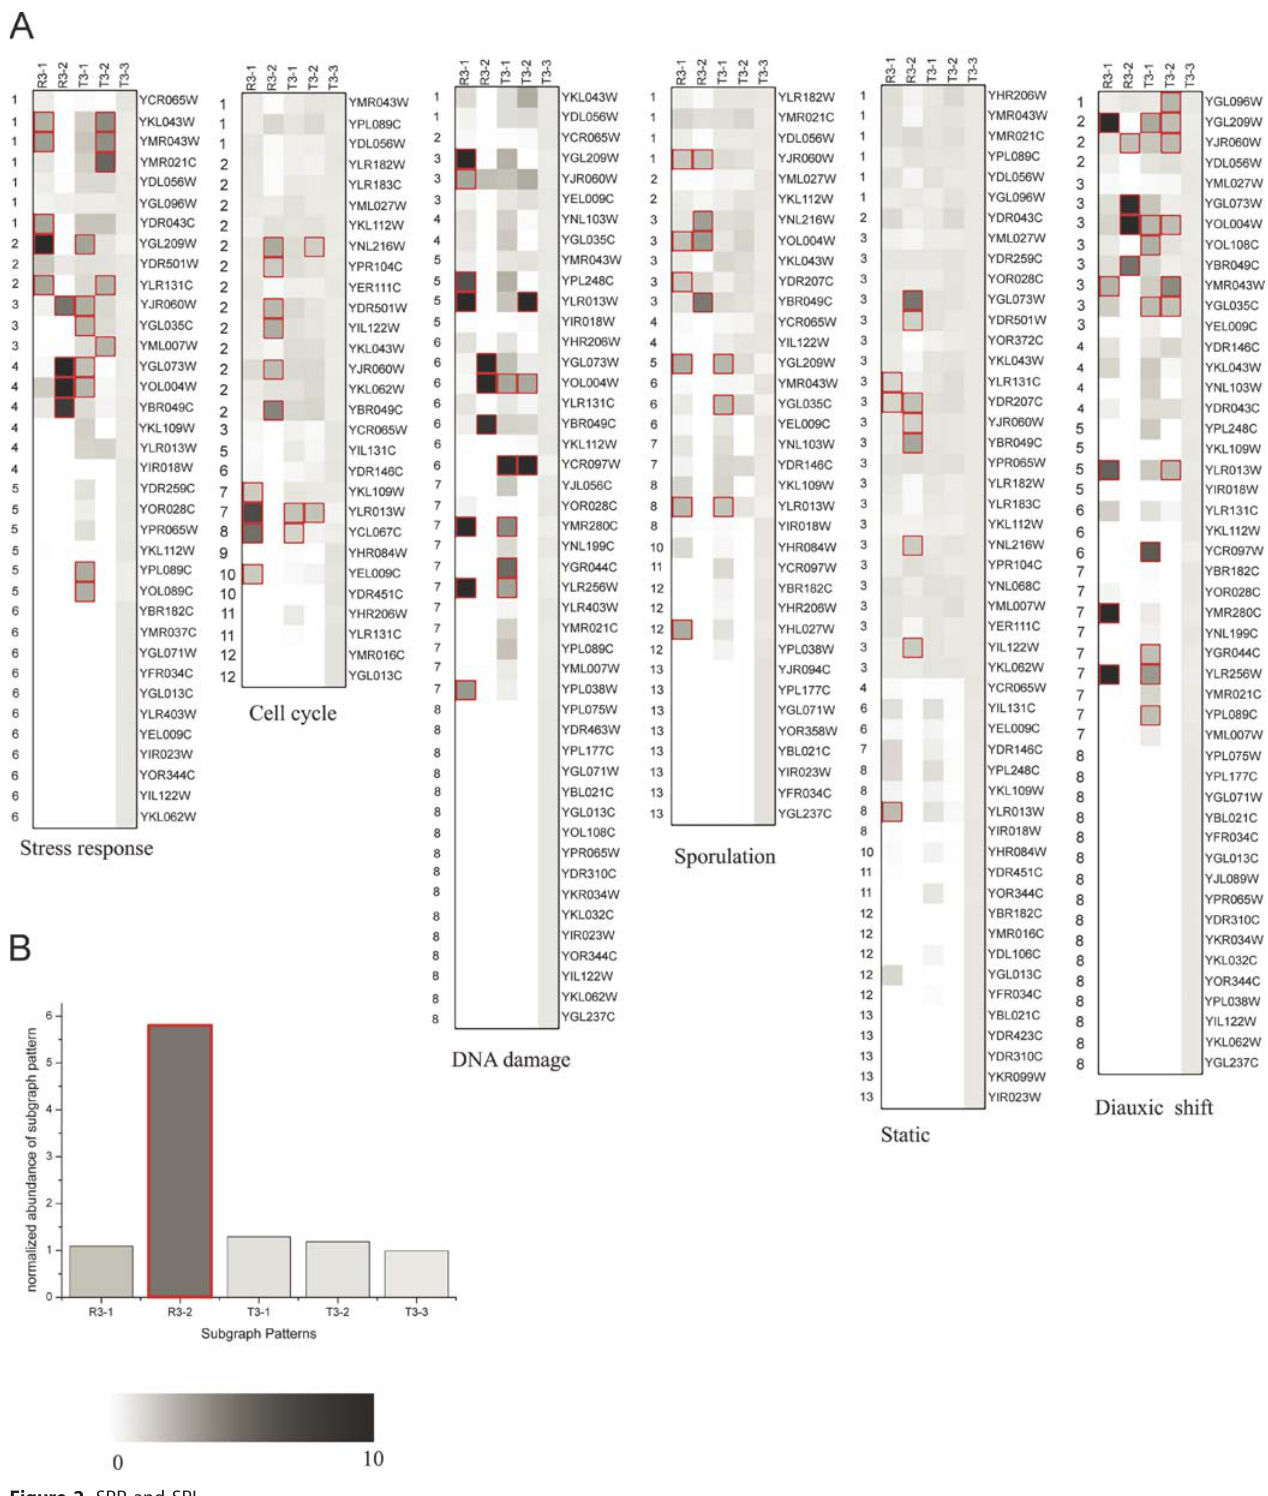
PLoS Computational Biology |